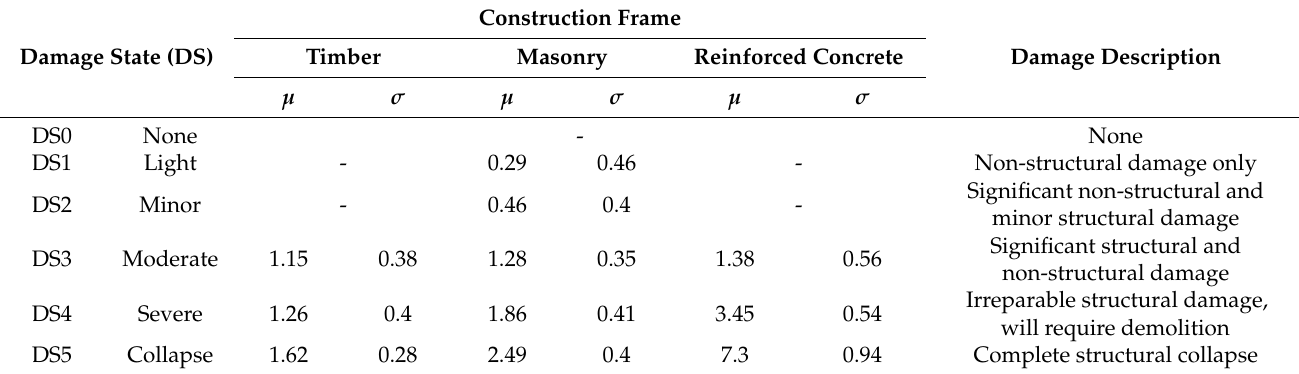
Table 2. Building fragility model parameters applied in this study.